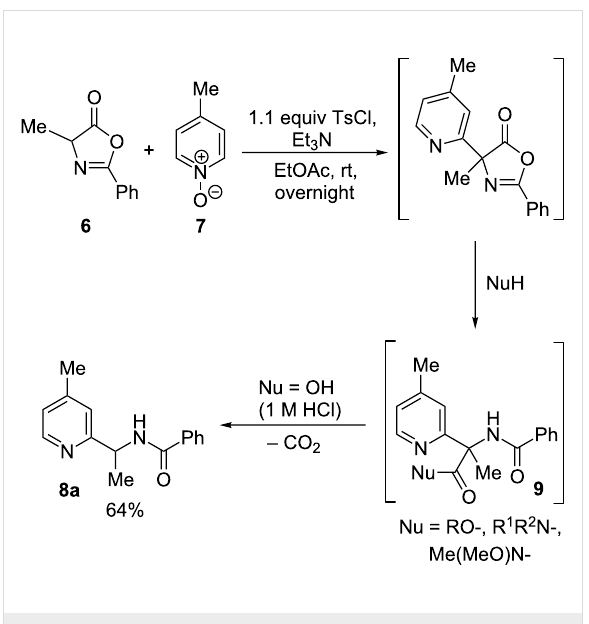
of an α -(amidoalkyl) anion equivalent with a pyridyl elec-